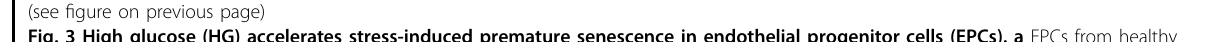
(Fig. 6e). The exosomes derived from ADSCs over- expressing Nrf2 improved levels of SMP30 and VEGF and increased VEGFR2 phosphorylation, whereas levels of NOX1 and NOX4 were signi fi cantly reduced (Fig. 6f – j; P < 0.001 vs. normal glucose). A similar pattern occurred with the in fl ammatory cytokine levels of IL-1 β , IL-6, and TNF- α , which were all further reduced by the over-